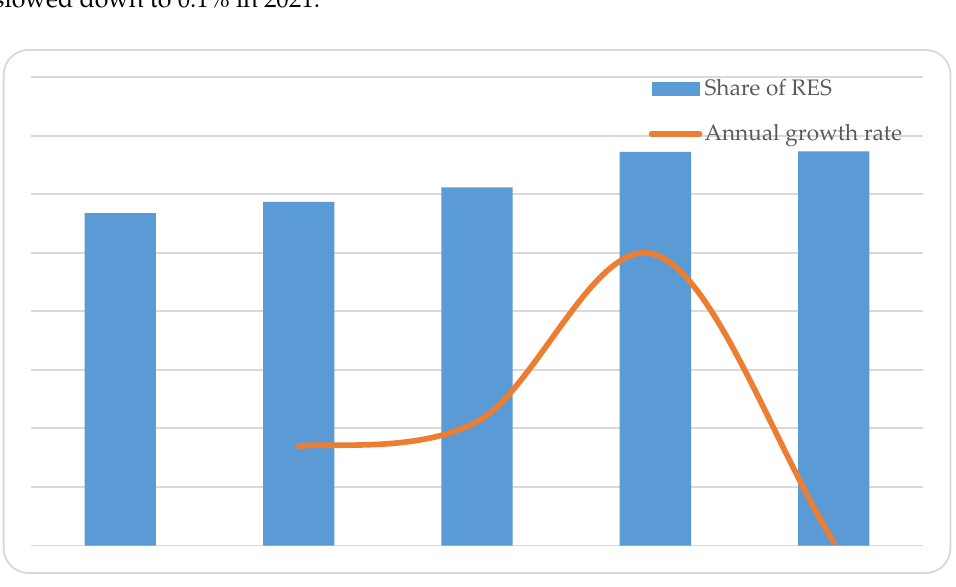
Figure 4. Energy consumption, world data, %.